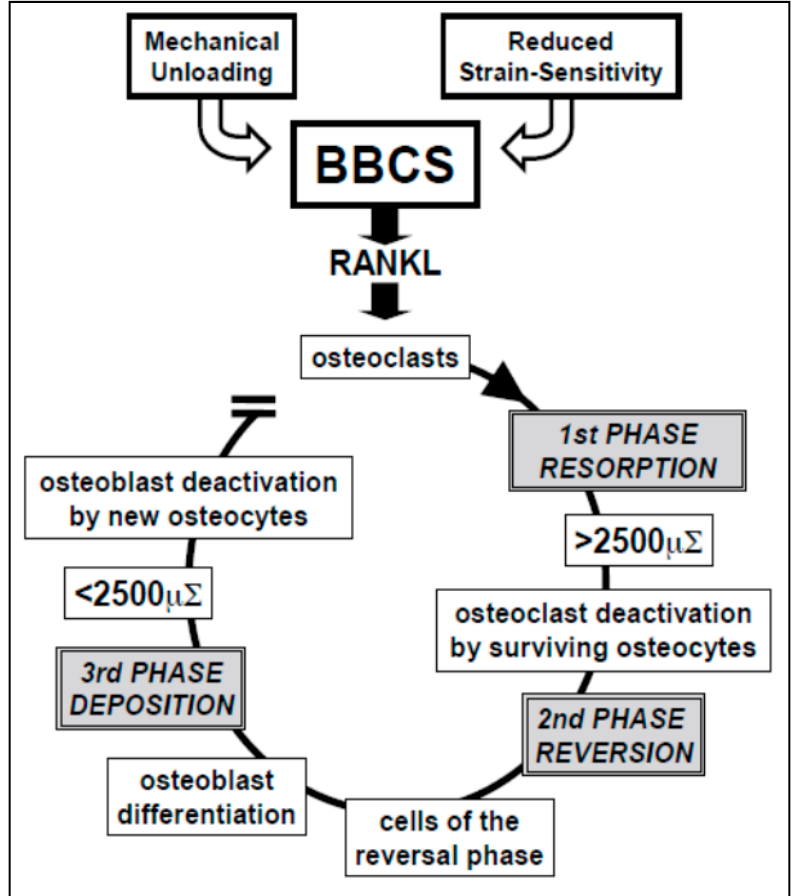
Figure 11. Schematic drawing of postulated BBCS role during bone remodeling cycle. See text for explanation.